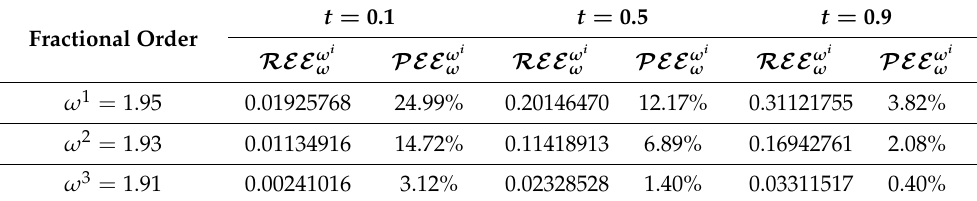
Table 3. The relative error and percent error estimations for ω = 1.9.